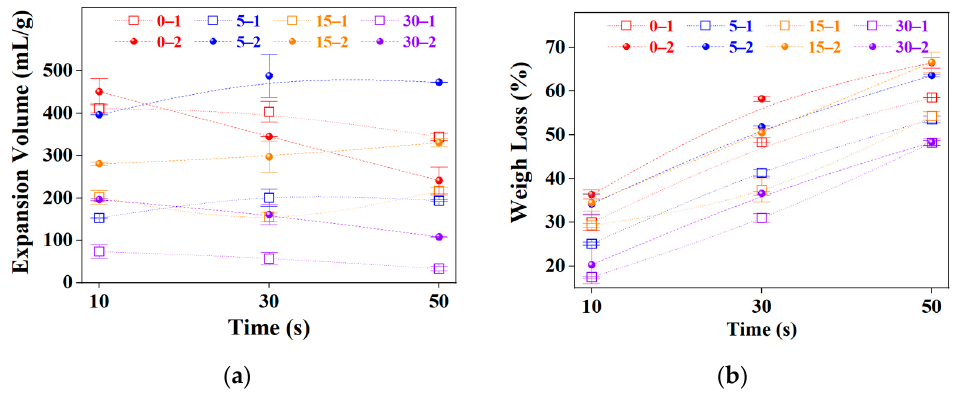
Figure 9. EV variation ( a ) and mass loss ( b ) during microwave heating as a function of time and peroxide concentration. Top series 2 (50%) and bottom series1 (30% H 2 O 2 ). EV and mass loss values are lower with IG products obtained with extended ball